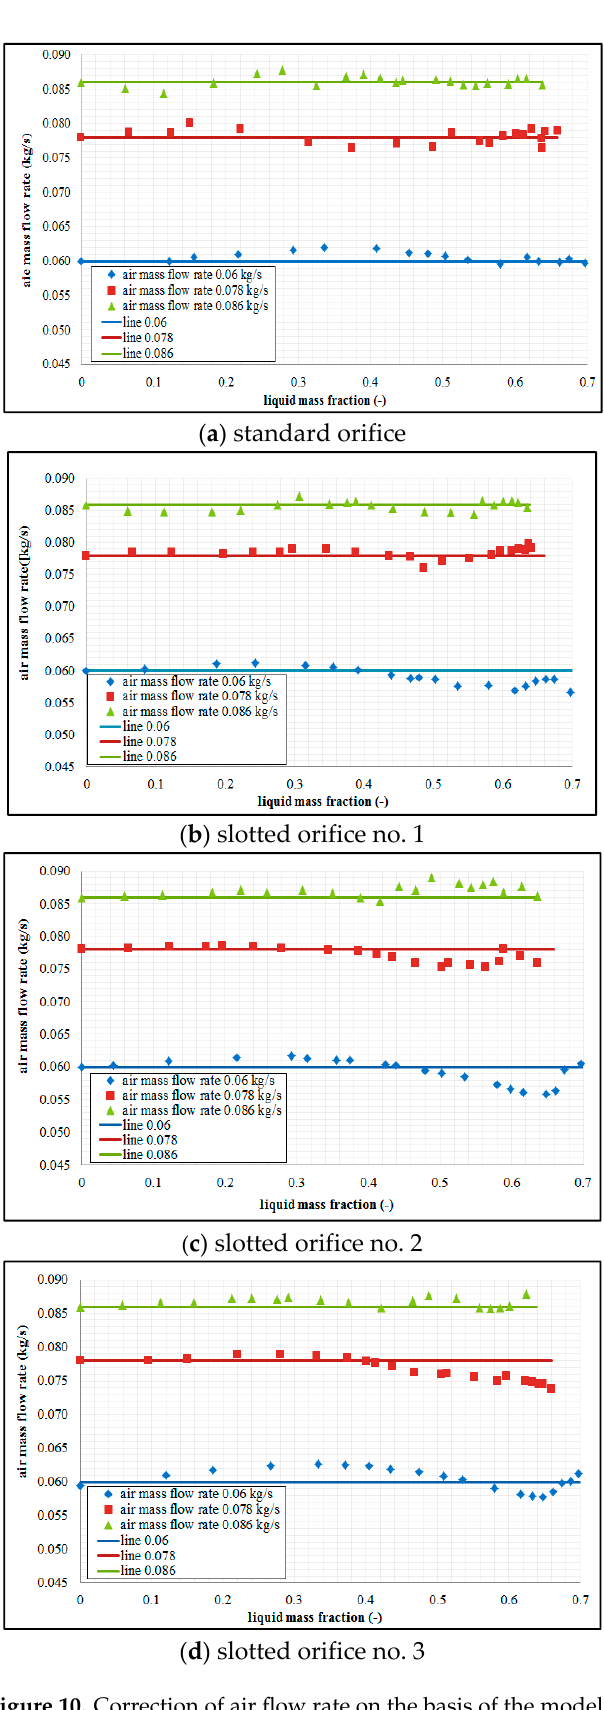
Figure 10. Correction of air flow rate on the basis of the model developed by authors.